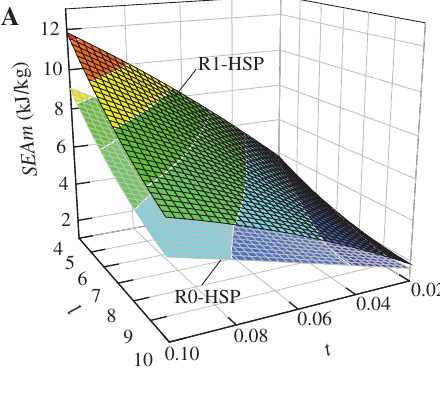
Table 8: Optimal results for Opt.1 under σ